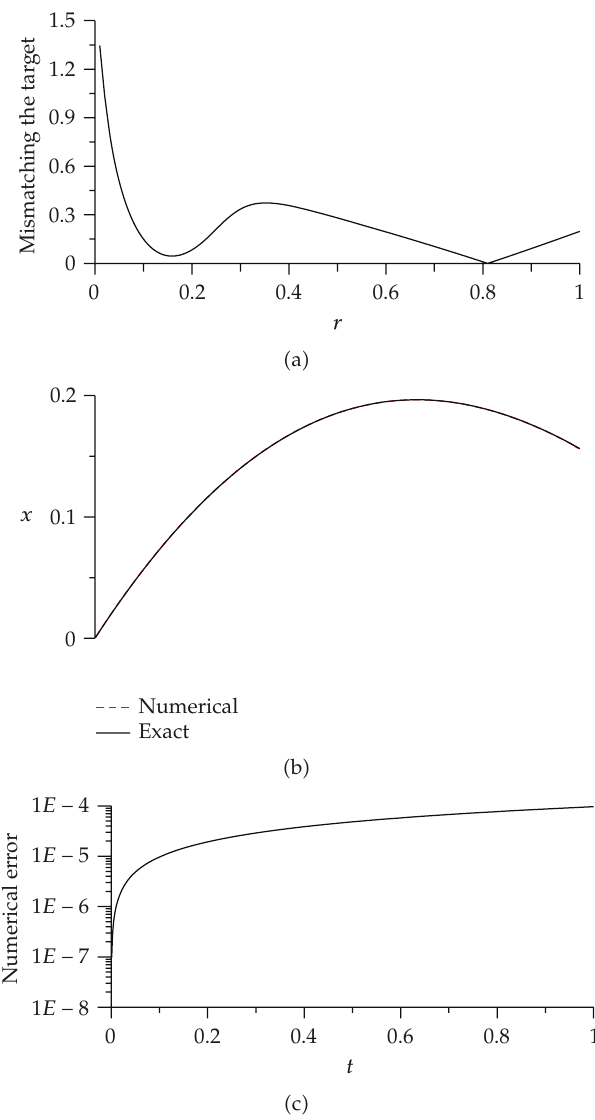
Figure 3: For example 2: (cid:3) a (cid:4) showing the error of mismatching, (cid:3) b (cid:4) comparing numerical and exact solutions, and (cid:3) c (cid:4) displaying the